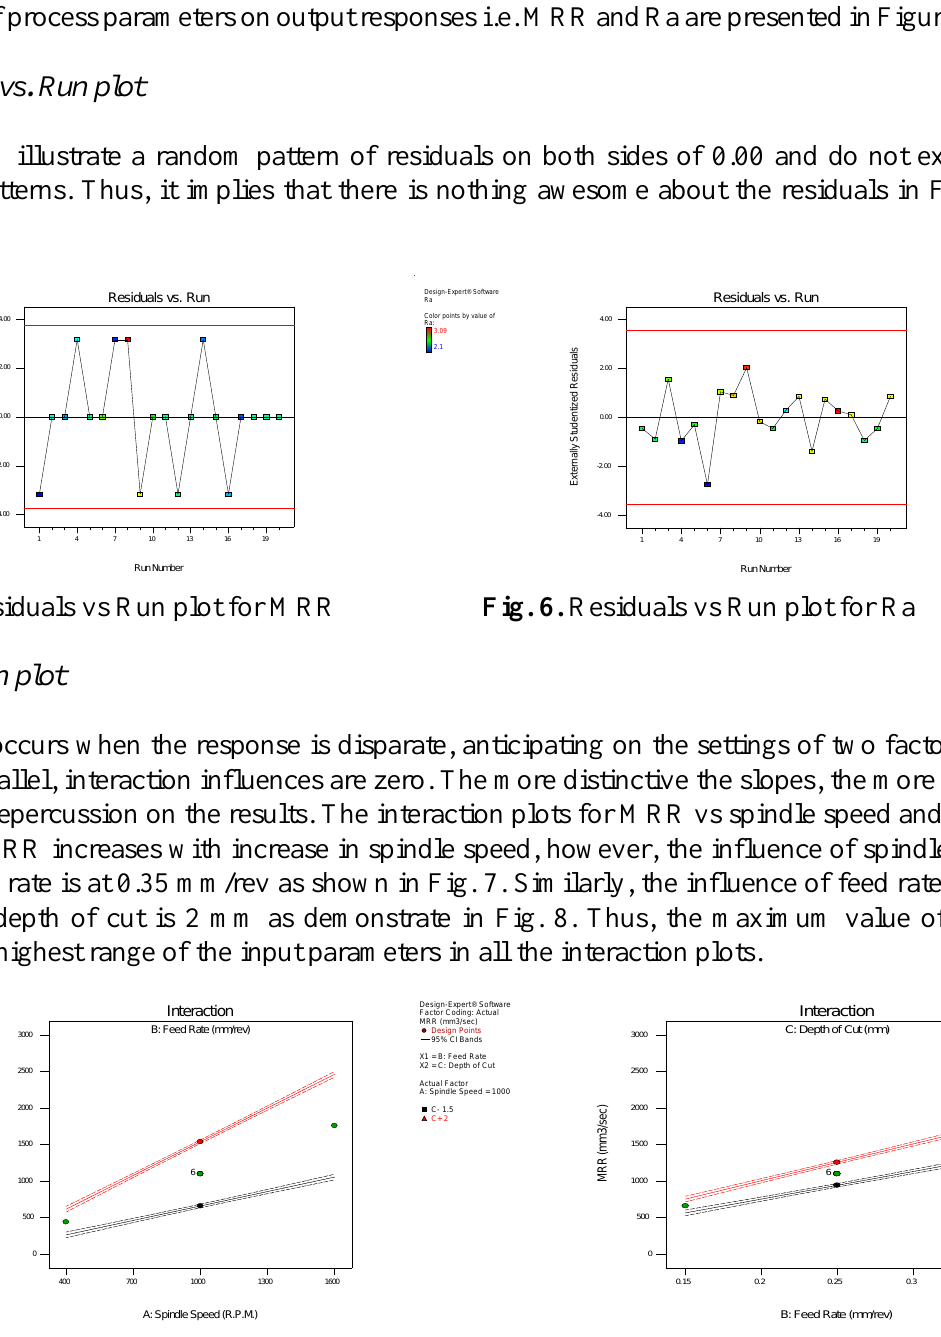
Fig. 7. Interaction plot for MRR vs Spindle speed and feed rate